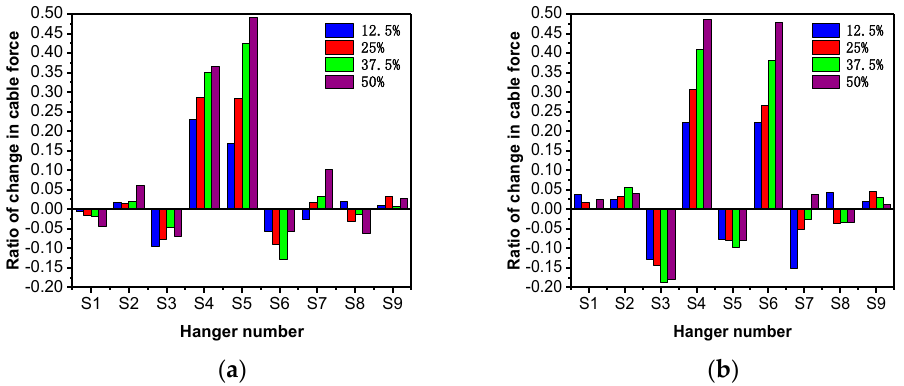
Figure 14. Damage identification results for EDC17–EDC24: ( a ) the preset damage hangers are S4and S5; ( b ) the preset damage hangers are S4 and S6.